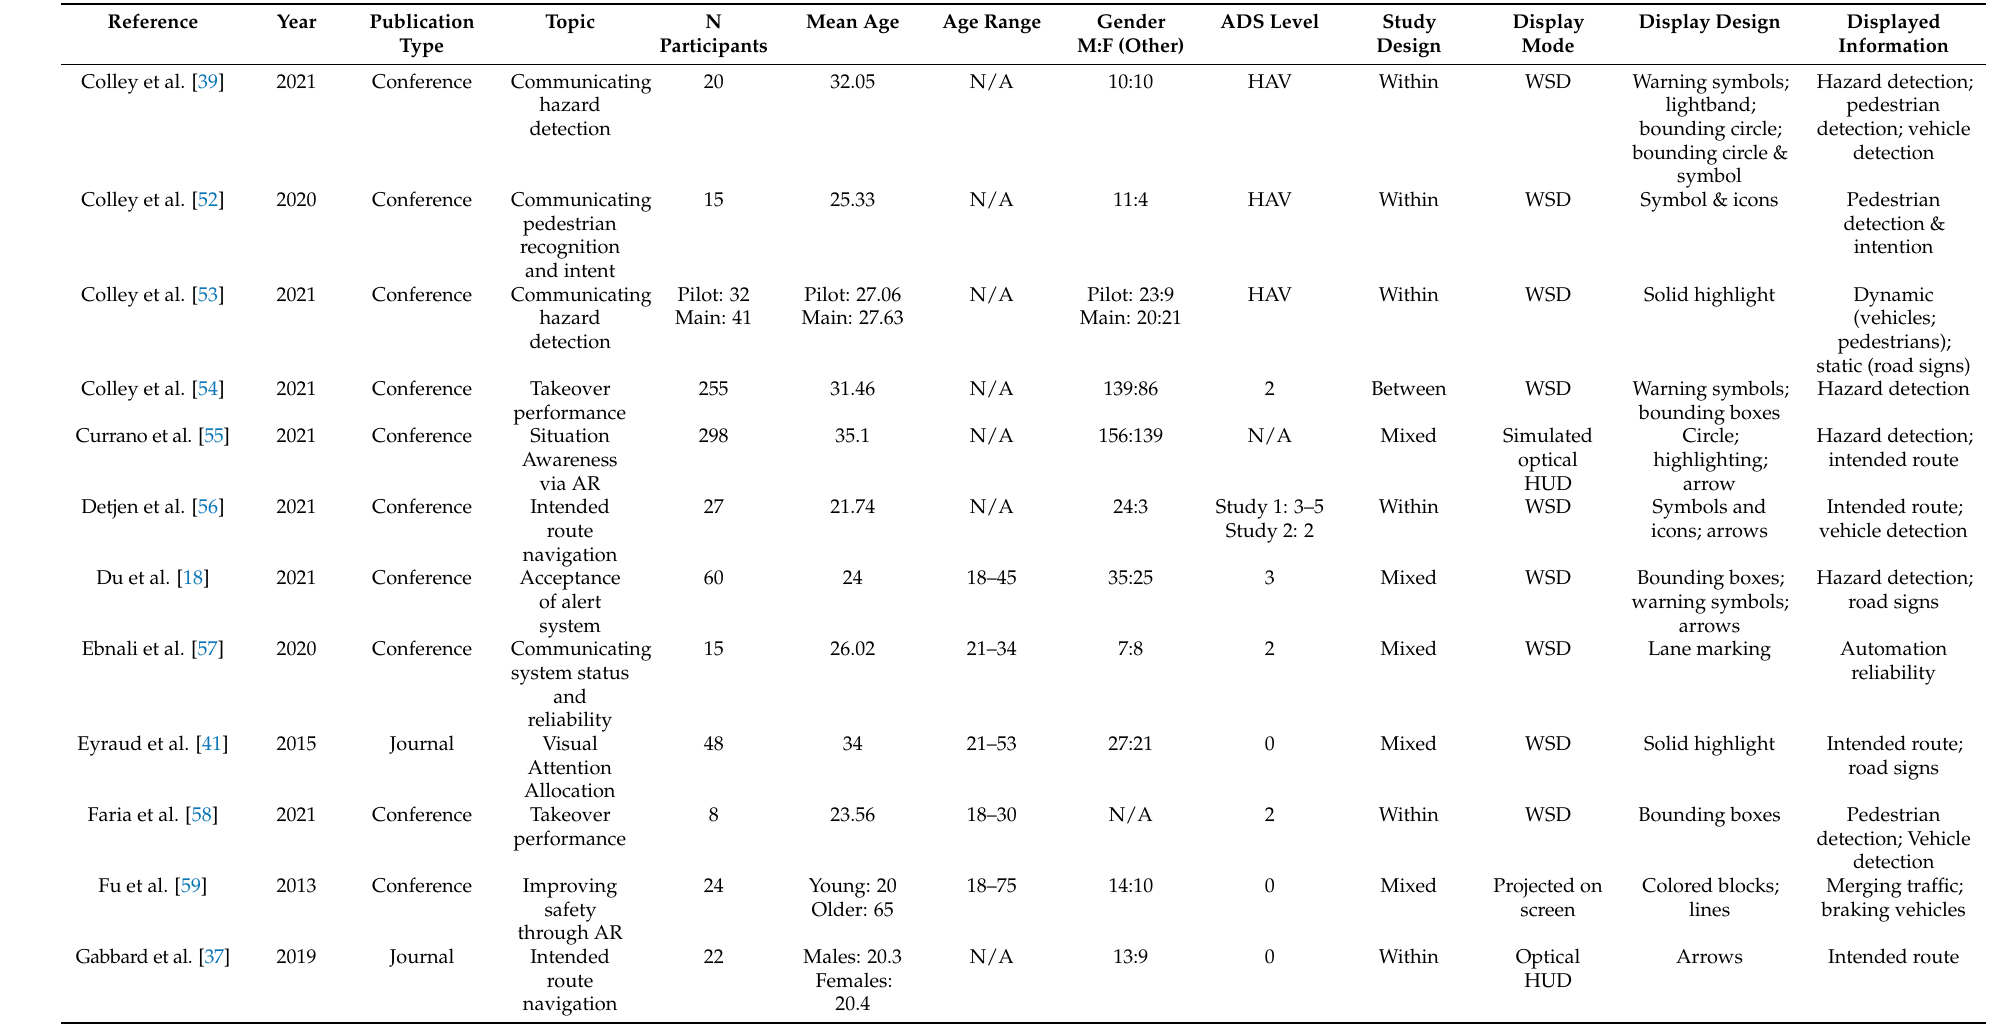
Table 1. Summary of article descriptives, study design, and display